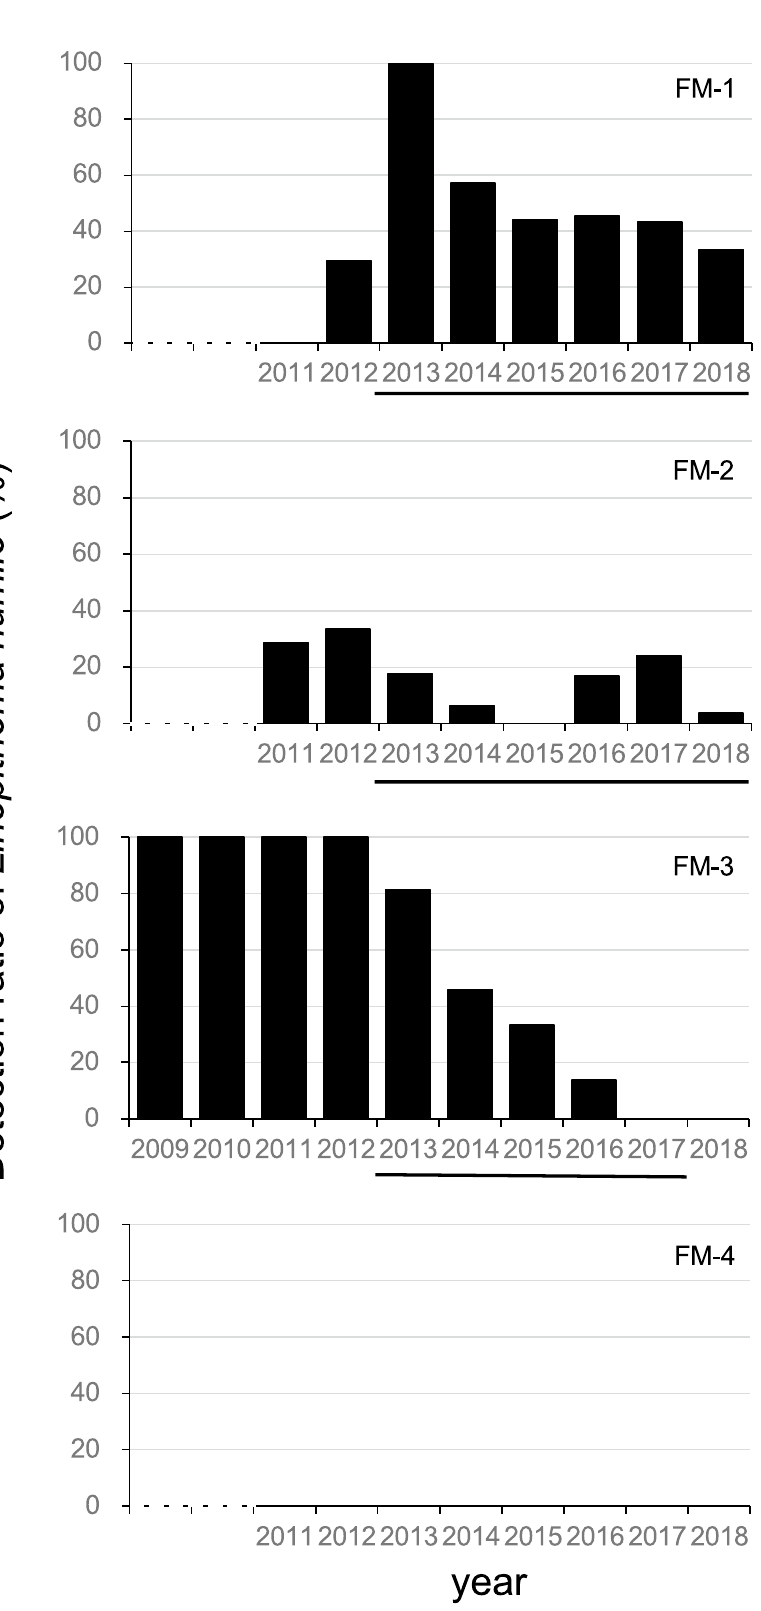
Figure 2. Annual change in the detection ratio of L. humile at Fushimi area. Bars indicate the period during which L. humile control was carried